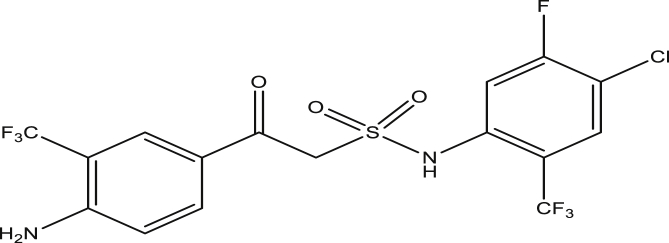
Compound 9e [2-(4-amino-3-(trifluoromethyl)phenyl)-N-(4-chloro-5-fluoro-2-(trifluoromethyl)phenyl)-2-oxoethanesulfonamide (pEC500.7327058)].